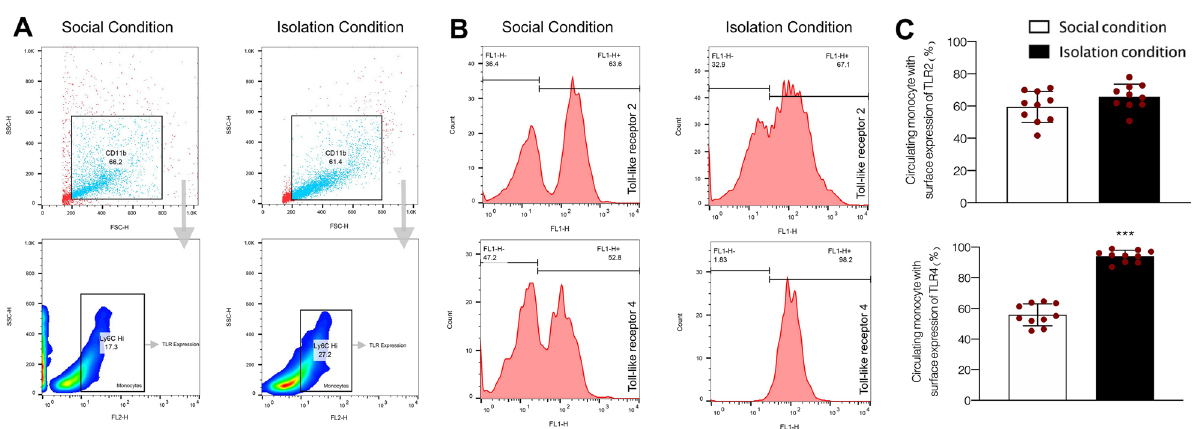
Figure 3. Gating strategy ( A ) and the expression of TLR-2 and 4 on circulating monocytes in both normal and isolated animals ( B and C ). Values are expressed as the mean ± S.E.M. (n = 10 in each group) results were analyzed using One-Way ANOVA followed by Tukey’s post hoc test. *** P < 0.001 compared to social conditioned